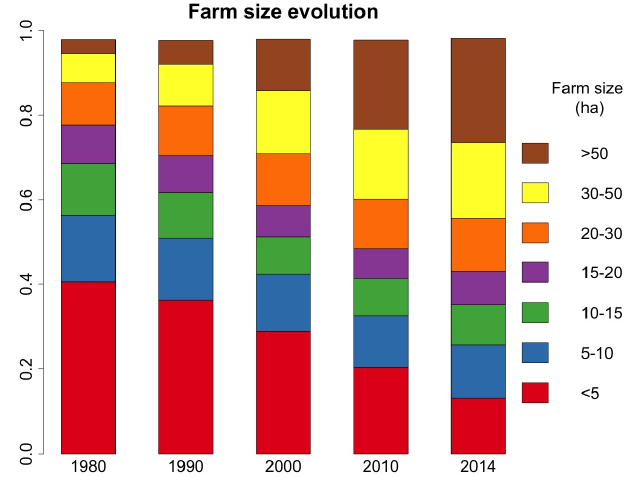
Figure 5. Evolution of the farm size distribution as a percentage of the total amount of farms from 1980–2014 in Belgium based on data from the agricultural surveys.